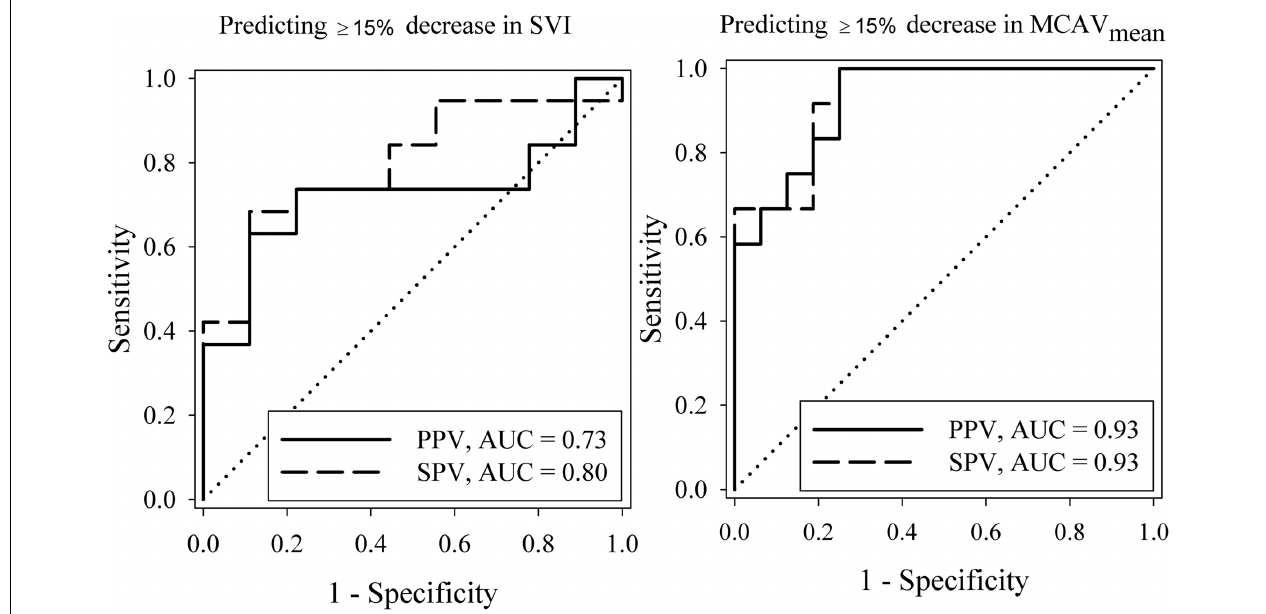
pressure variation; SPV, systolic pressure variation; AUC, area under curve; SVI, stroke volume index; MCAV mean , mean middle cerebral artery velocity.